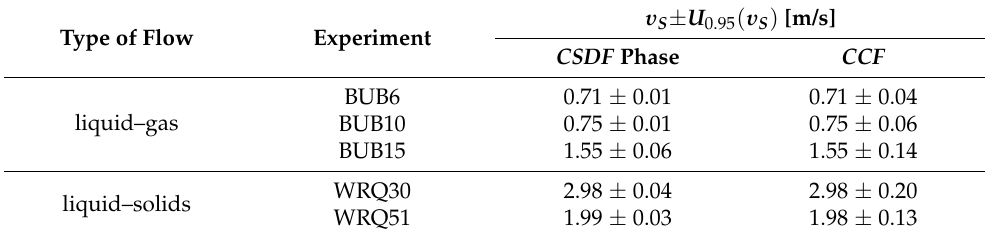
Table 1. Summary of the test